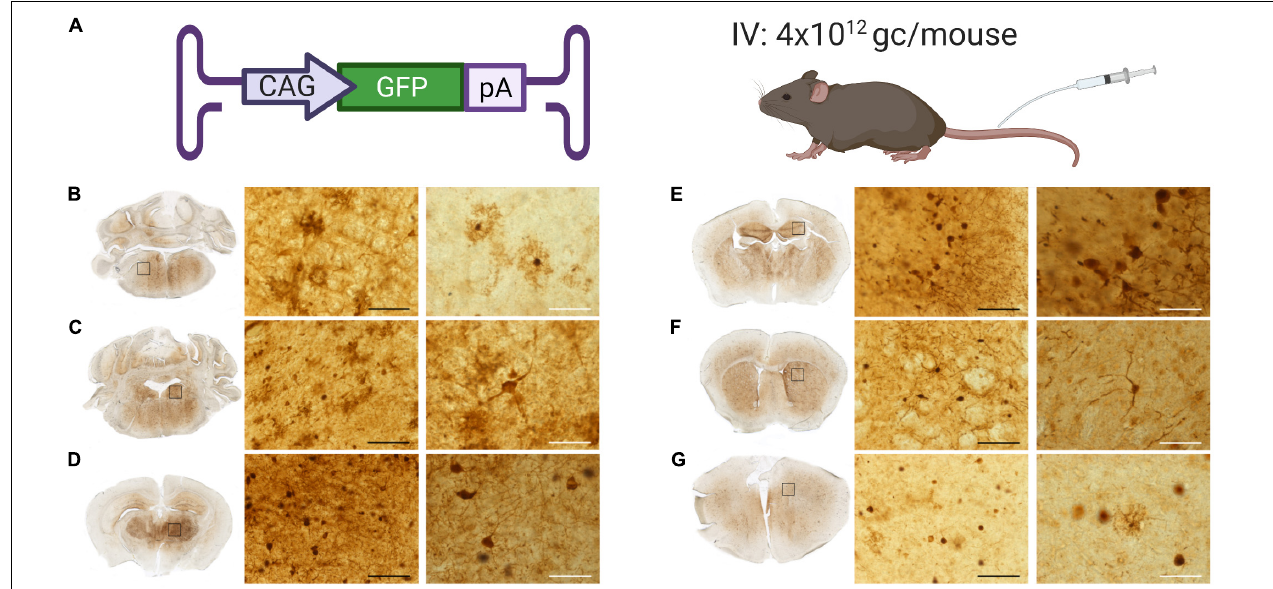
FIGURE 4 | GFP expression throughout the brain of mice administered with AAV9-PhP.B. (A) Cartoon depicting construct used, administration route, and dose used of 4 × 10 12 GC/mouse. Brains were extracted, fixed in 4% paraformaldehyde, embedded in gelatin, and serially cut by using a Vibratome to 50- µ m sections. GFP protein staining (shown in brown) in (B) the medulla, (C) the locus coeruleus, (D) the thalamus, (E) the hippocampus, (F) the striatum, and (G) the cortex. Rectangles show the location of the micrograph taken. The black scale bar represents 50 µ m, and white bar represents 250 µ